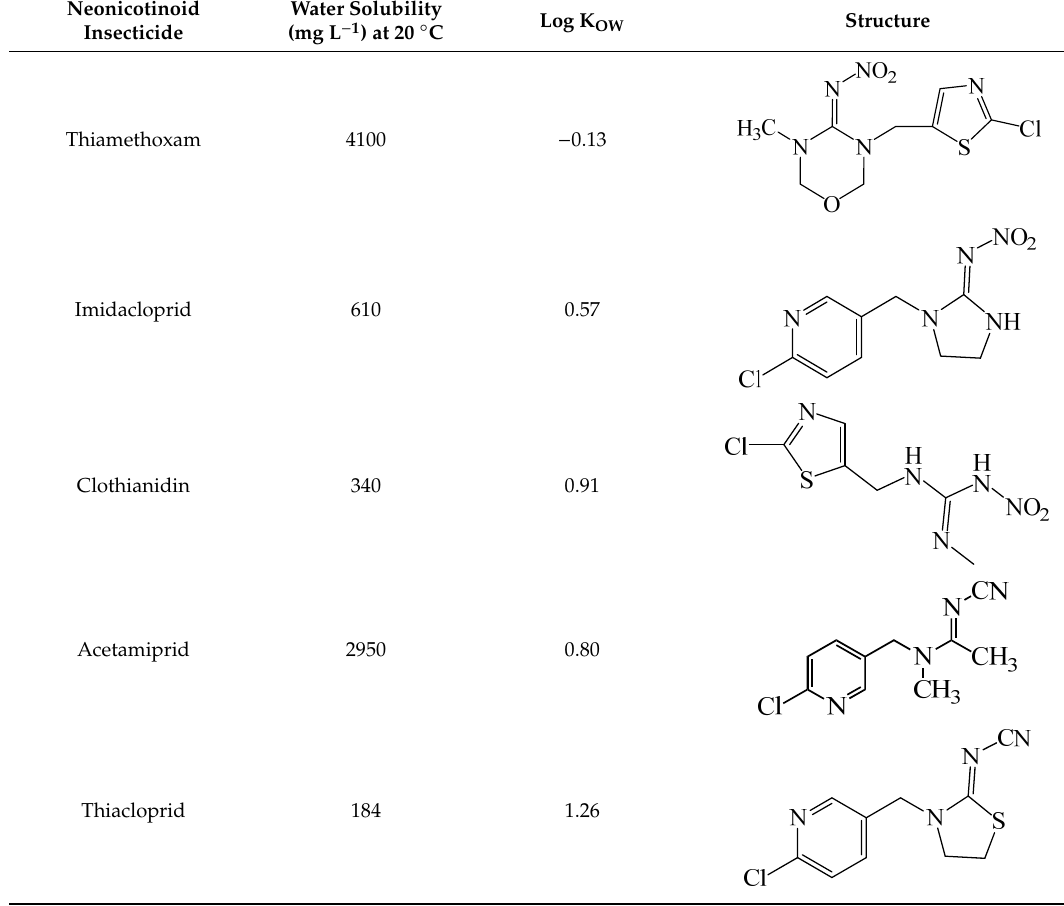
Table 4. Properties of the studied neonicotinoid insecticides with regard to other chemical classes. Neonicotinoid Insecticide